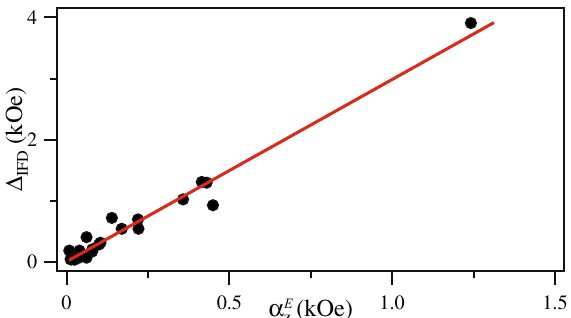
Figure 2. Measured width of the IFD distribution, (cid:31) IFD , plotted as a function of the axial component of the E interaction field α z measured from the IRM/DCD remanence curves. The straight line corresponds to the fit of � IFD = 3 α z